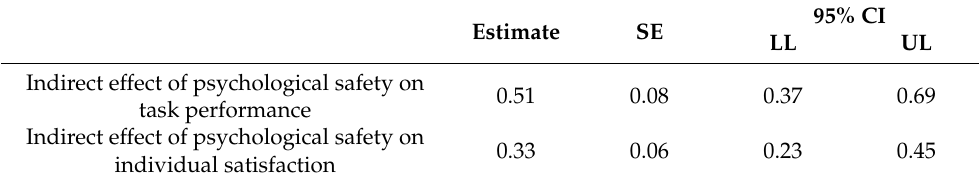
Table 6. Indirect effects and bootstrap results.